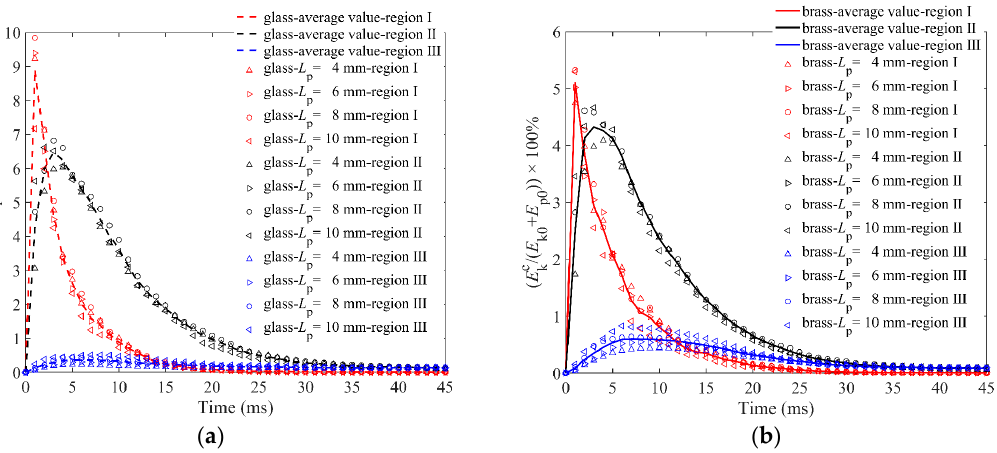
Figure 12. Kinetic energy of particles in the cup E c in three regions versus time for granular bed with L p = 4 mm, 6 mm, 8 mm, 10 mm elongated particles: ( a ) is for the glass impactor, and ( b ) is for the brass impactor.